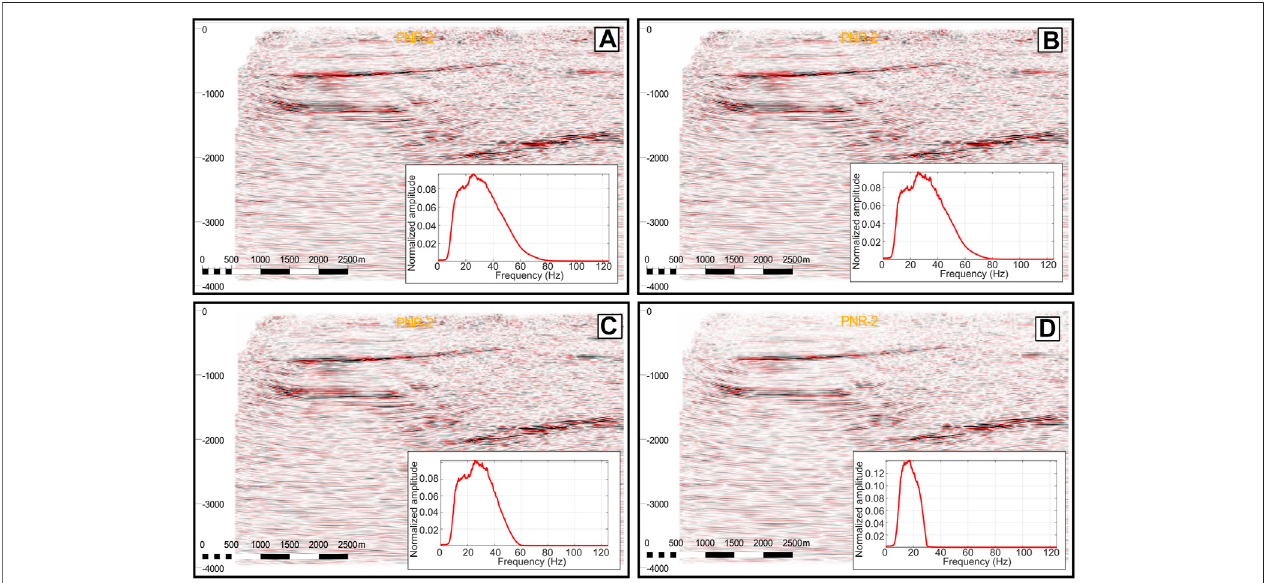
FIGURE11| Comparison ofseismic sections adjacent tothePrestonNew Road2 borehole. (A) un fi ltered; (B) lowpass fi ltercut at 90 Hz; (C) low pass fi lter cutat 60 Hz and d) a low pass fi lter cut at 40 Hz. The section is orientated E-W (XL 1234).